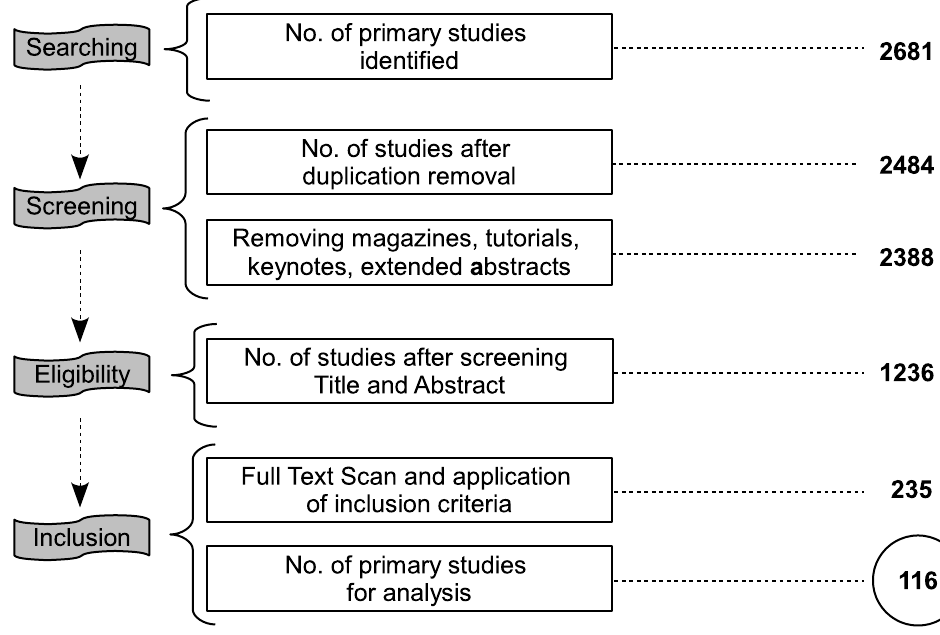
Fig 2. Primary studies selection